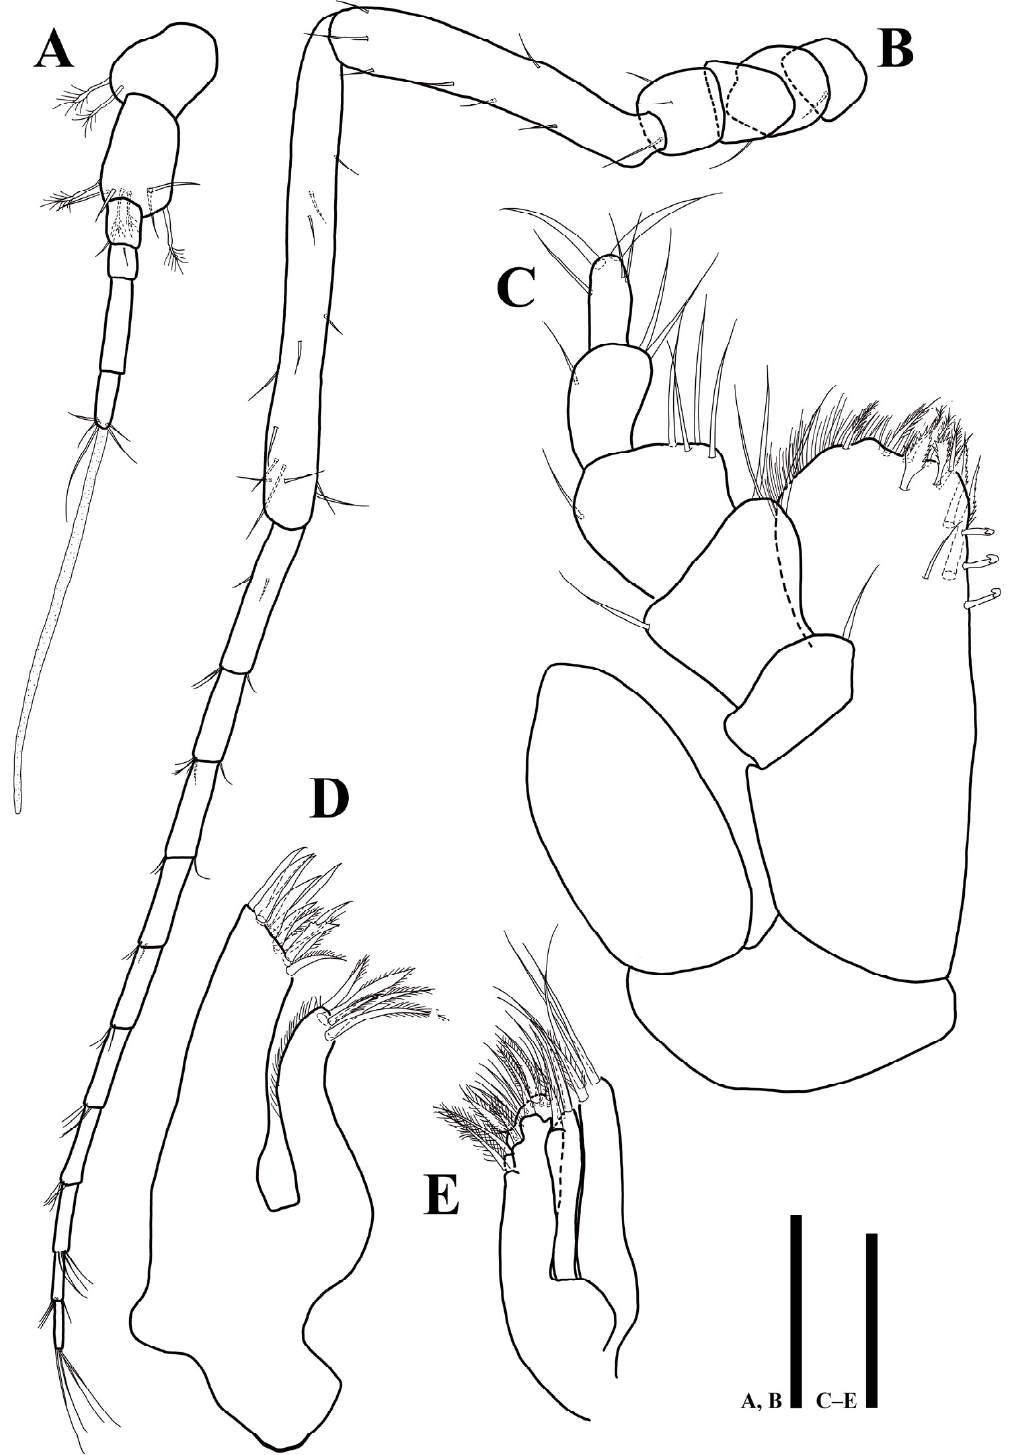
Figure 3. Uromunna mundongensis sp. n. holotype male: ( A ) antennula; ( B ) antenna; ( C ) maxilliped; ( D ) maxillula; ( E ) maxilla. Scale bars = 100 μ m ( A , B ), 50 μ m ( C ‒ E ). Pereopods: coxae of pereonites 4 ‒ 7 visible in dorsal view, each coxa with two or three simple setae (Figure 2B); pereopod 1 subchelate, dactylus of pereopods partly covered by articular plate projected from distal margin of propodus.